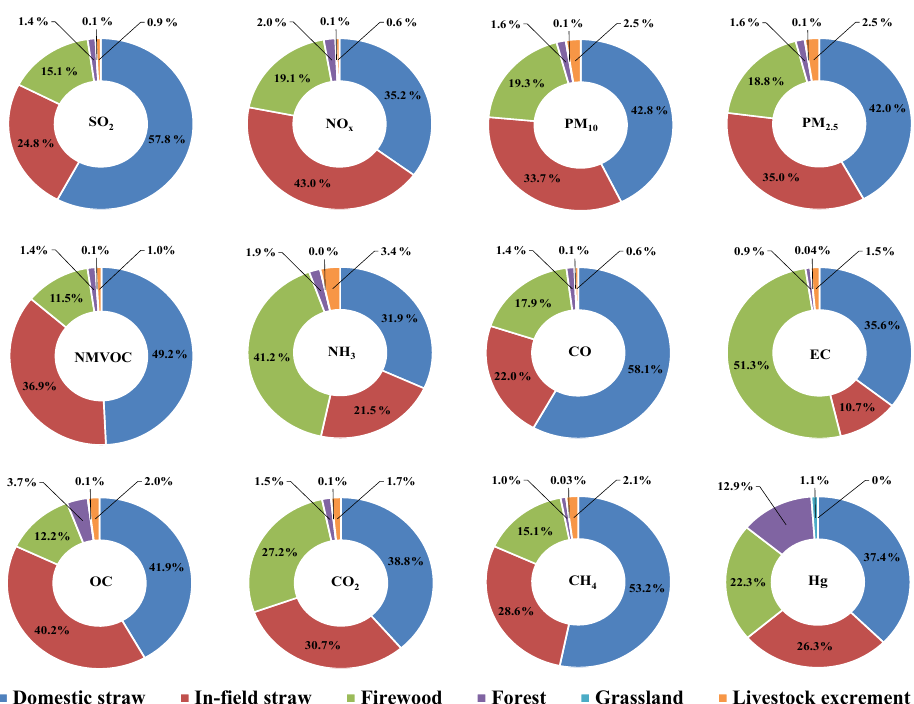
Figure 2. Contributions of different sources to total biomass burning emissions in China in 2012.